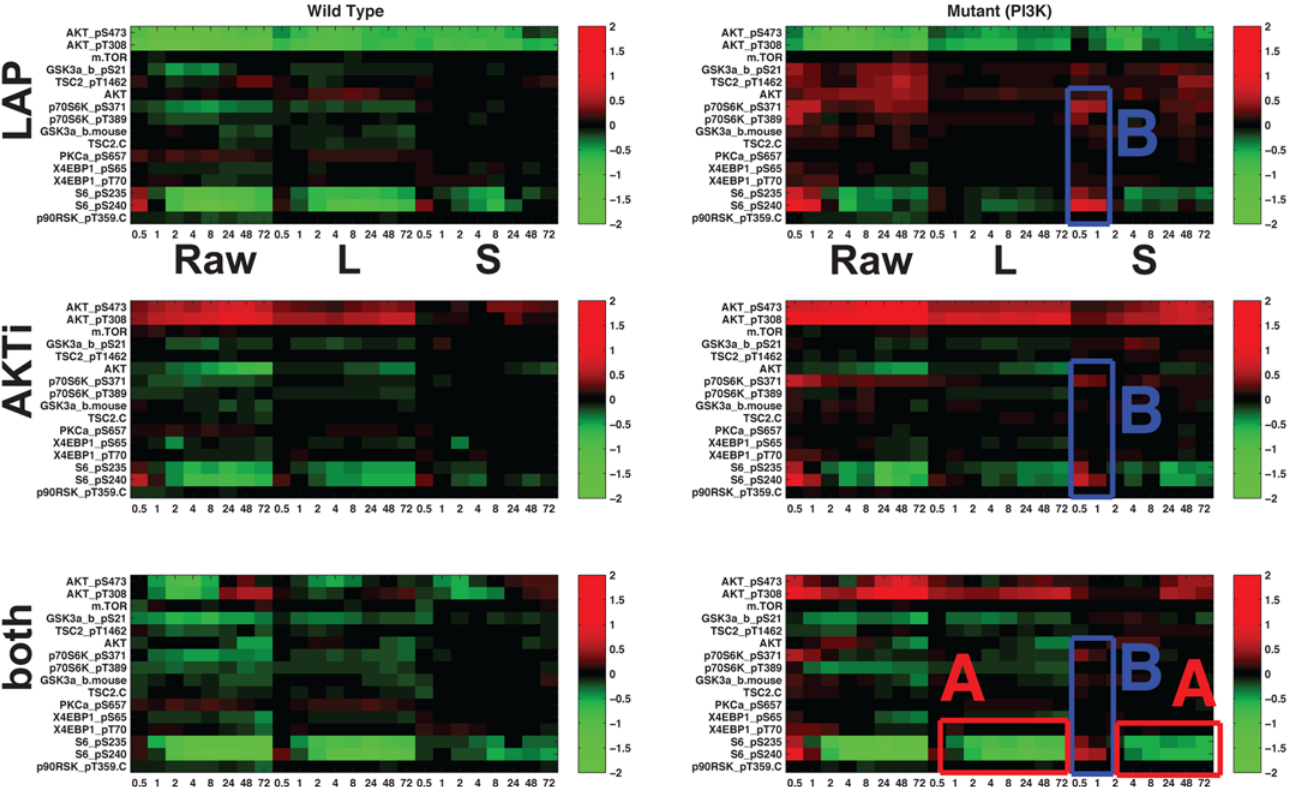
Fig 9. Heat maps showing average response based on both raw data and disentanglement result within subtype to targeted therapeutics in Fig 8: (left) HER2+ / wild type , (right) HER2+ / PI3K mutant . Each representation consists of average responses of raw RPPA, low-rank component and sparse component. Each row represents targeted therapeutics alone and in combination ( LAP, AKTi, both ). (A) In the PI3K mutation with applying both inhibitors, full inhibition of pS6RP is observed (B) the main difference between wild-type and PI3K mutant is the response of pS6RP and p70S6K